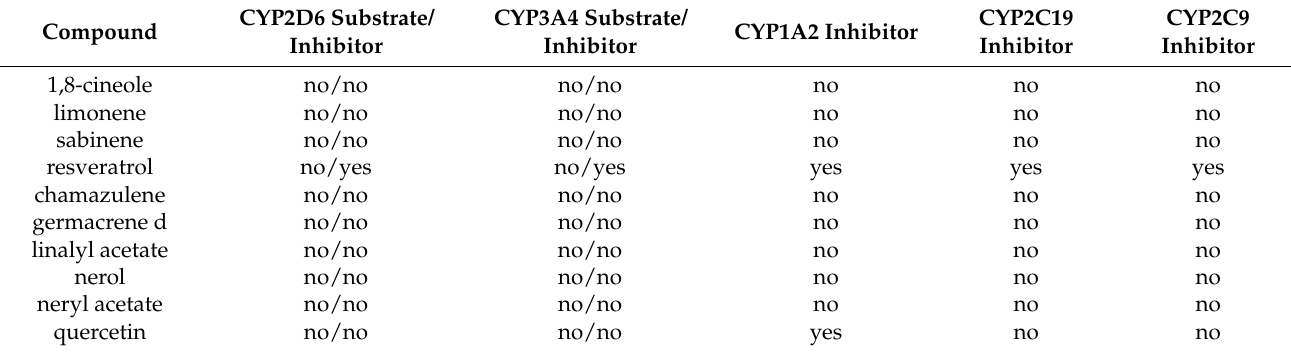
Table 4. The inhibitor/substrate features of natural compounds at CYP2D6, CYP3A4, CYP1A2, CYP2C19 and CYP2C9. CYP2D6 Substrate/ Compound Inhibitor